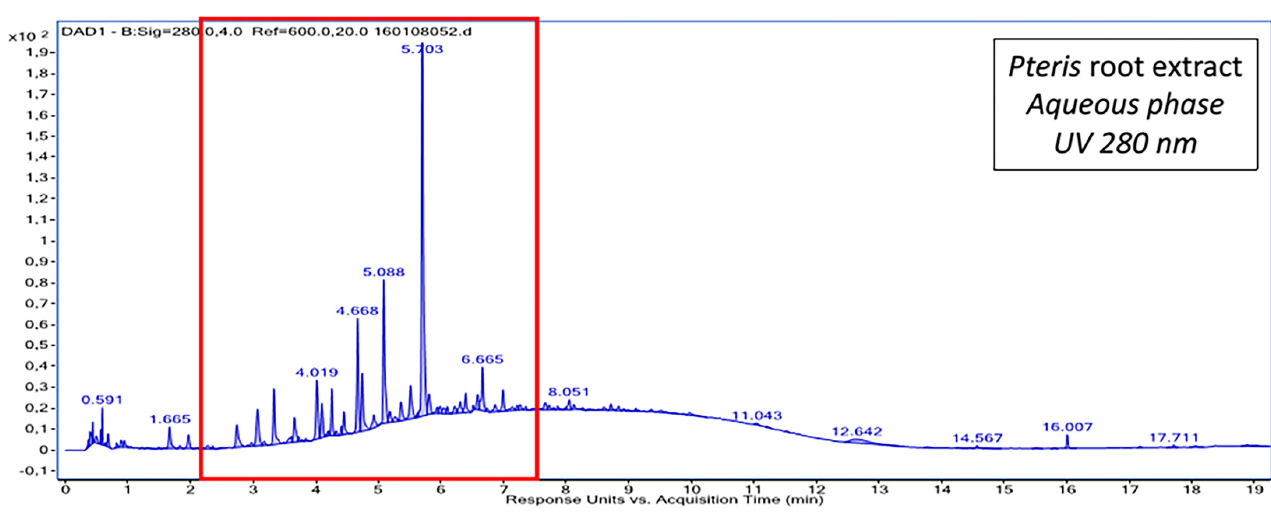
Figure A1. Ultra high performance liquid chromatography (UHPLC) chromatogram with UV detector at 280 nm of Pteris vittata L. roots aqueous fraction.